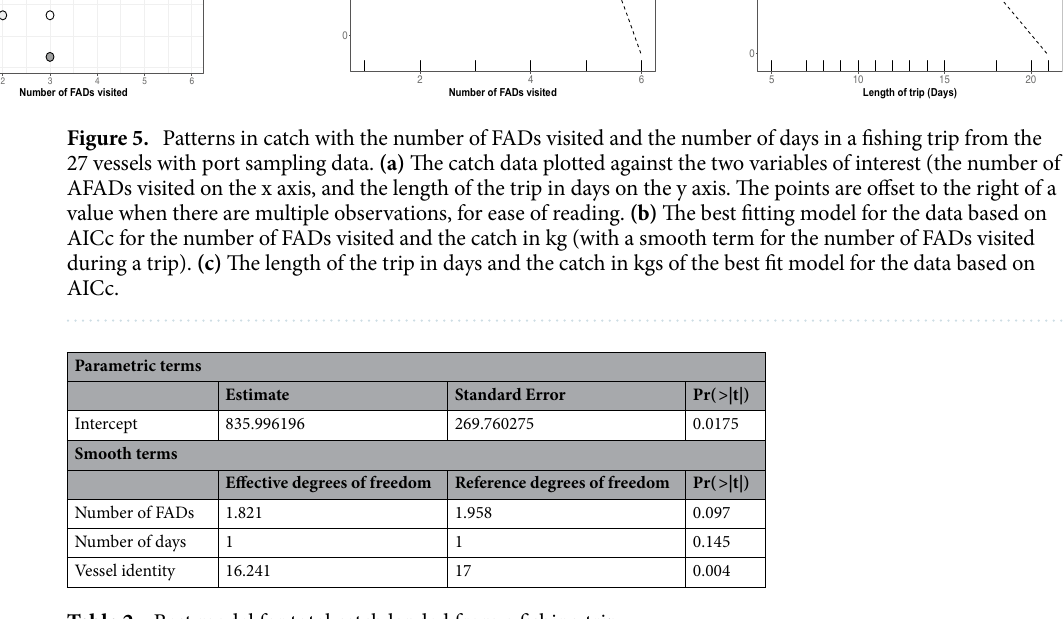
Table 2. Best model for total catch landed from a fishing